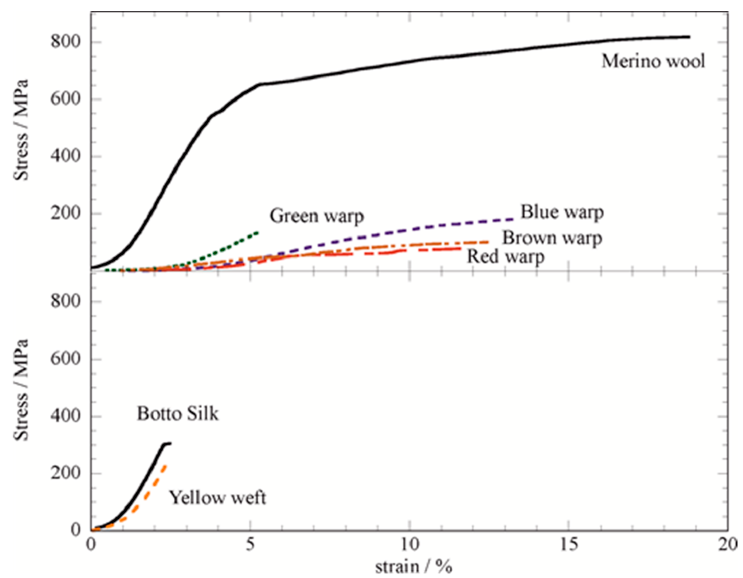
Figure 2. Stress vs. strain of commercial Merino wool, “Botto” silk and the Sixteenth Century yarns. Table 1. Tensile properties at 25 ◦ C of commercial Merino wool, “Botto” silk and the Sixteenth Century yarns.